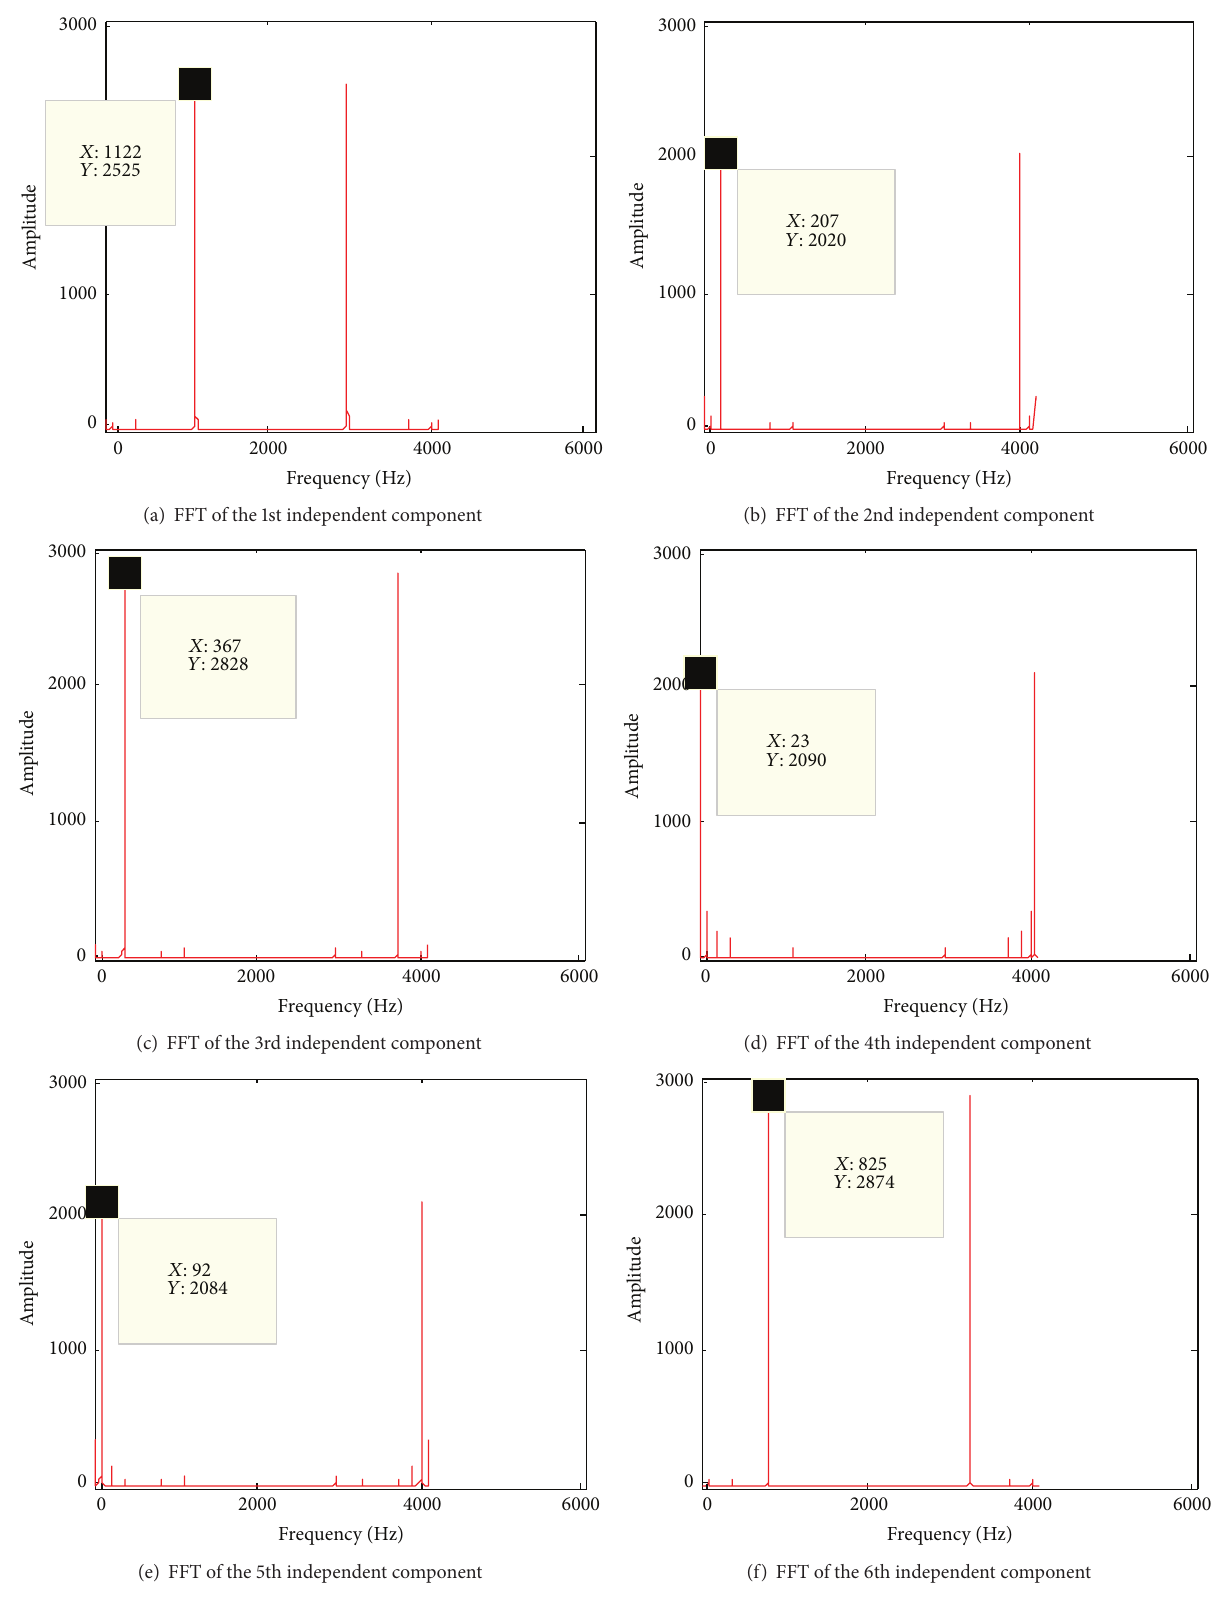
Figure 9: FFT of each independent component identified by maximum likelihood estimation with stochastic gradient descent